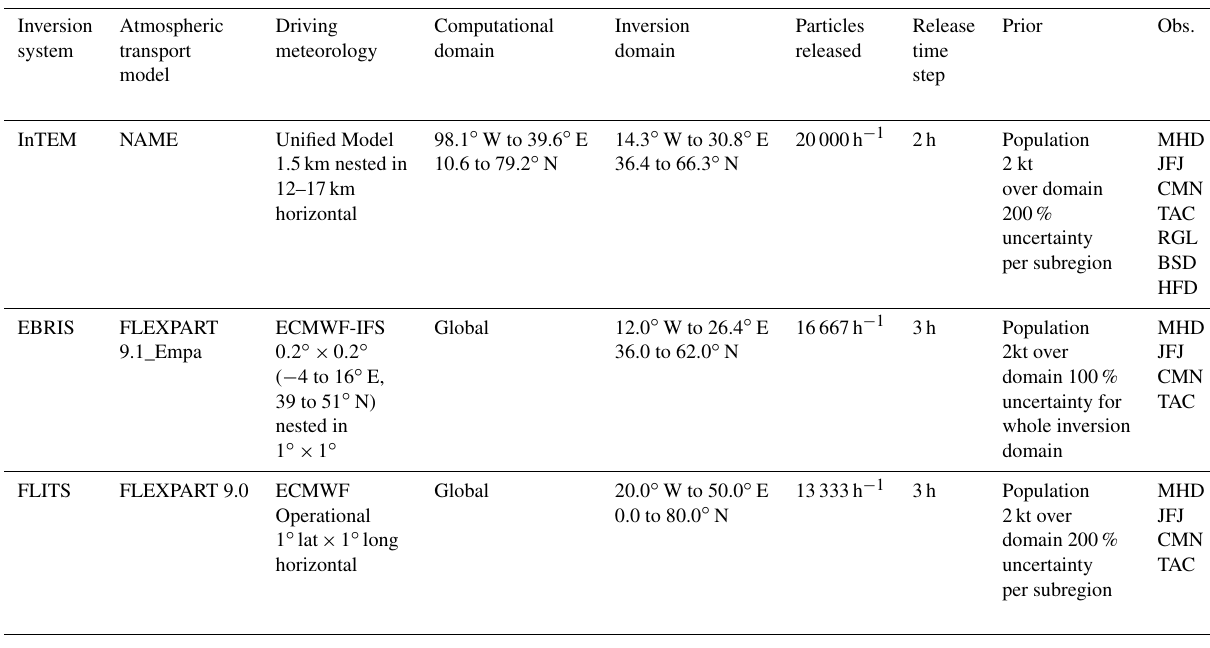
Table 3. The European setup of each inversion system run each year during 2013–2018: the meteorology, atmospheric transport model (ATM), and geographical domains over which the ATMs are run; number of particles released; inversion time steps, prior information; and observations